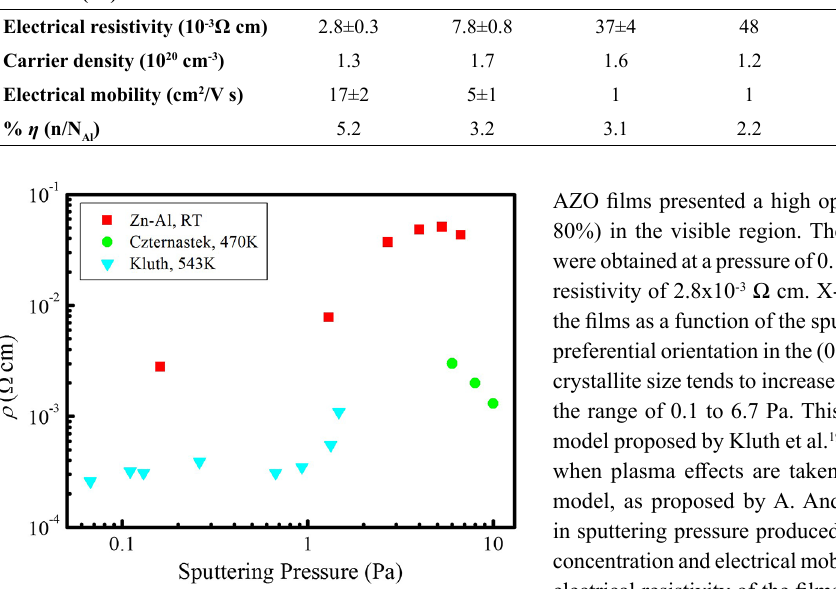
Table 4. Experimental and calculated values of the electrical properties of the AZO films synthesized from metallic Zn-Al (5 at.%) target. Pressure (Pa)